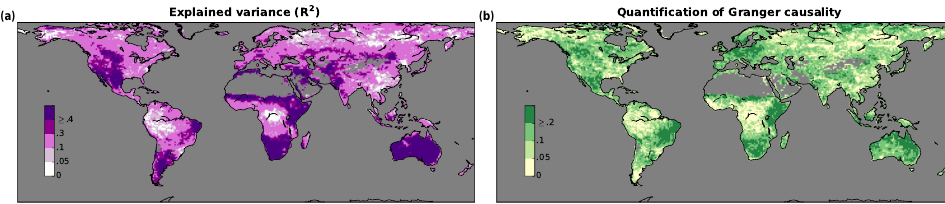
Figure 5. Non-linear Granger causality of climate on vegetation. (a) Explained variance ( R 2 ) of NDVI anomalies based on a full random forest model in which all climatic variables are included as predictors. (b) Improvement in terms of R 2 by the full random forest model with respect to the baseline random forest model that uses only past values of NDVI anomalies as predictors; positive values indicate (non-linear) Granger causality.